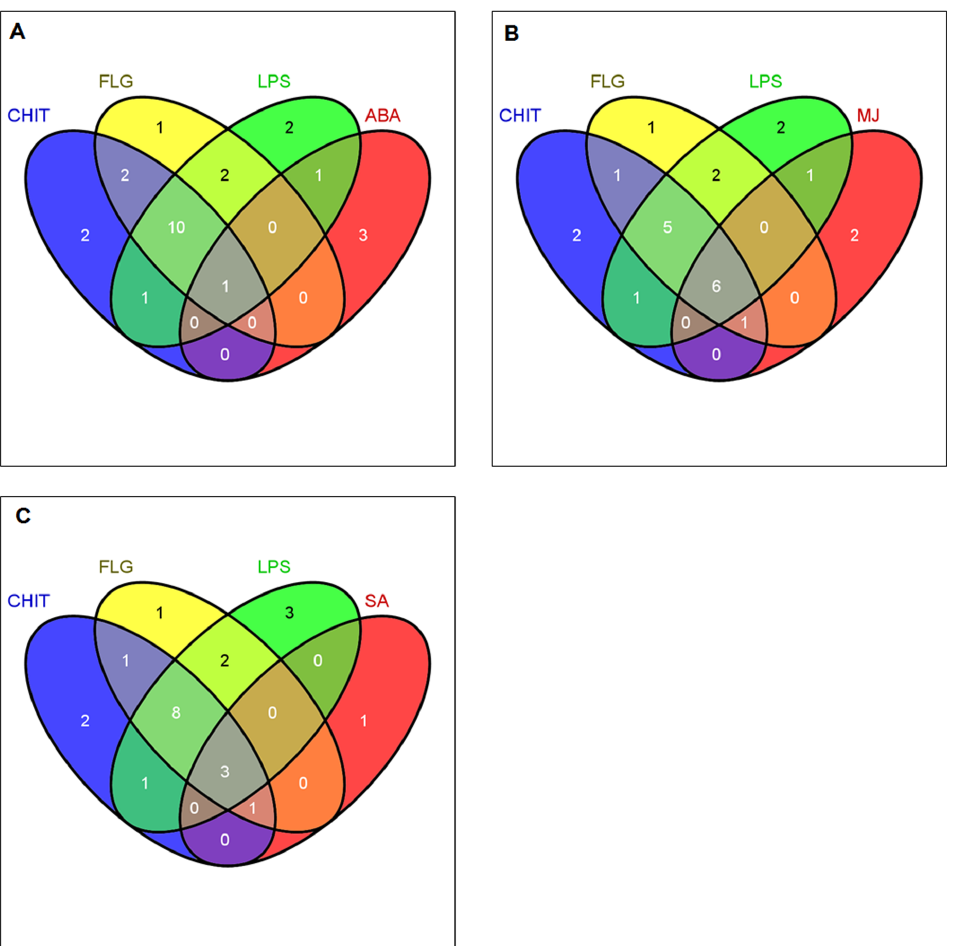
Fig 8. Venn diagrams of induced metabolites in elicited tobacco cells. Comparison of metabolites induced by MAMPs (lipopolysaccharides, chitosan and flagellin peptide-22 to ( A ), absciscic acid, ( B ) methyljasmonate and ( C ) salicylic acid. The diagrams show overlapping and distinct metabolites indicated by the numbers in the intersections and circles